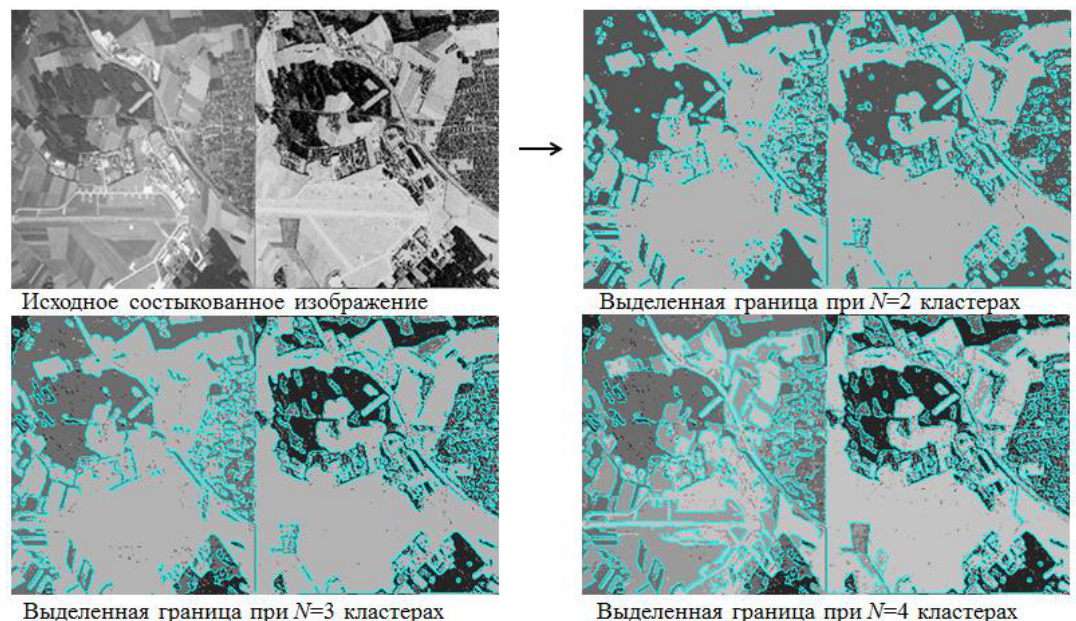
Figure 3 - boundary isolation by the Canny operator on piecewise-constant